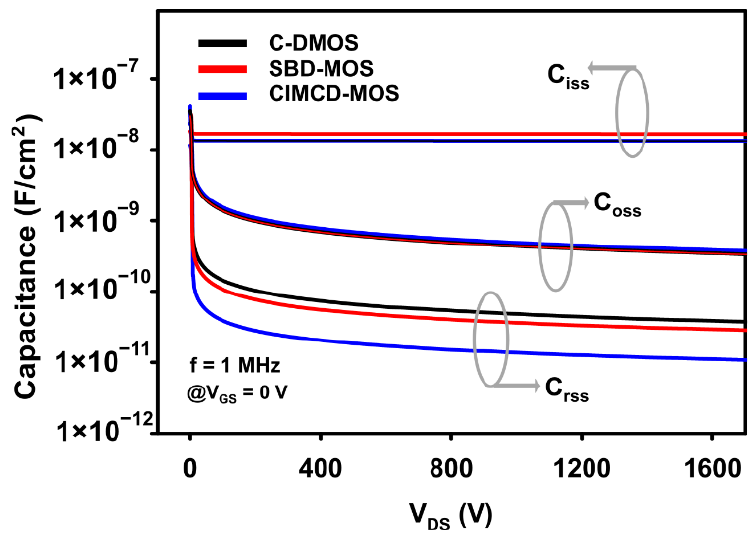
Figure 9. Comparison of the parasitic gate capacitance of the C – DMOSFET, SBD – MOSFET, and CIMCD – MOSFET.